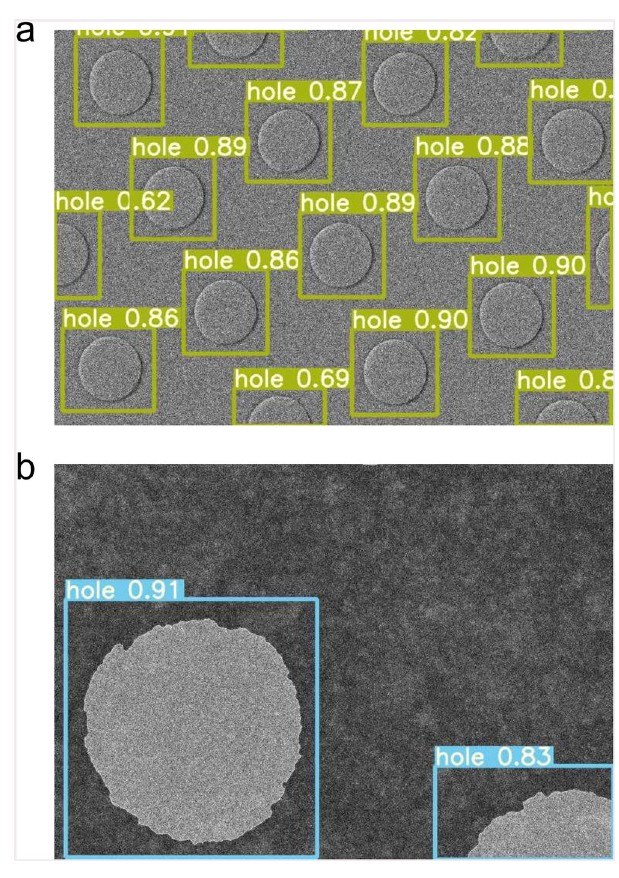
Fig. 4 Hole detection in different conditions. a Carbon holes taken at 2,500×. The hole size is ~1.5 μ m. b Holes on a gold grid (Quantifoil UltrAuFoil R 1.2/1.3) taken at 8,000×. Histogram equalization was not used for better detection of the gold holes. The hole size is ~1.2 μ m.